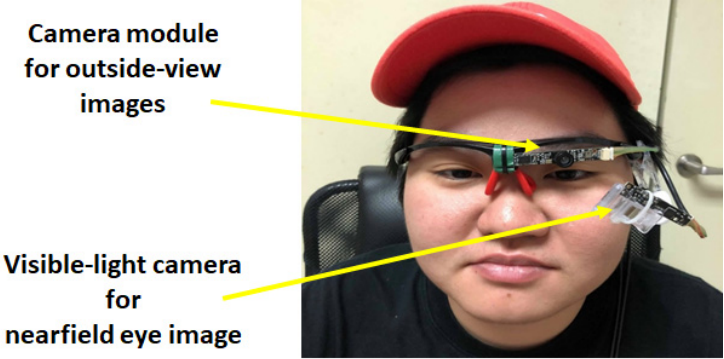
Figure 3. The operational flow of the proposed visible-light based wearable gaze tracker.